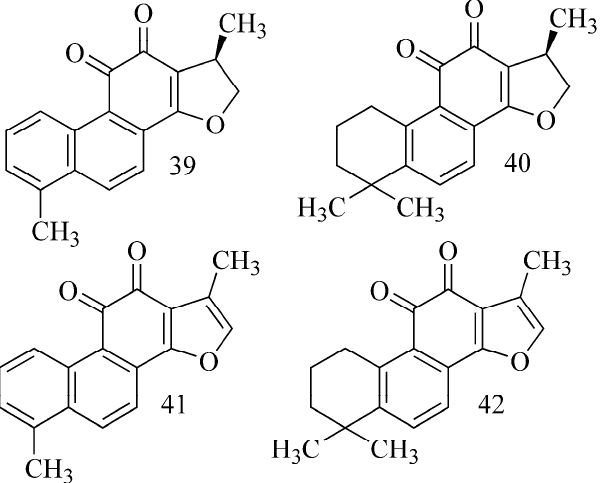
Figure 14. Chemical structures of dihydrotanshinone I ( 39 ), cryptotanshinone ( 40 ), tanshinone I ( 41 ) and tanshinone IIA ( 42 ).